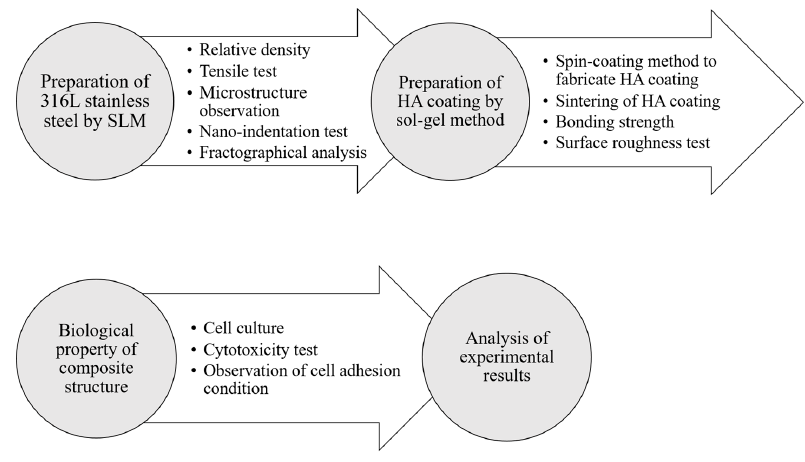
Figure 1. A flow chart of the work.